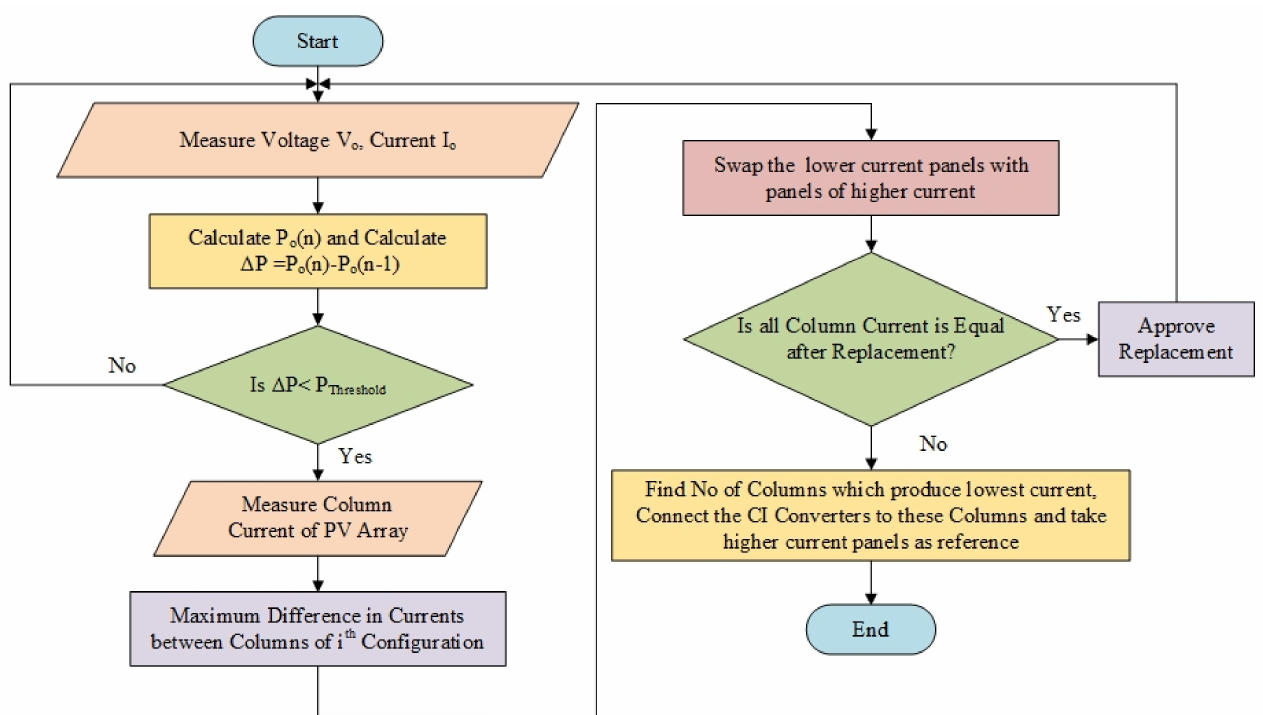
Figure 8. Algorithm for the Half-Bridge Current Injection (HBCI)